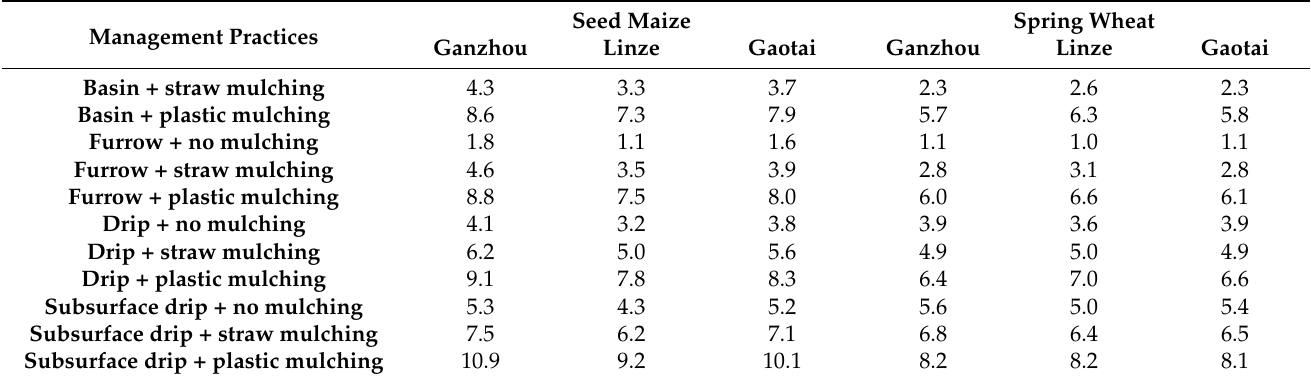
Table 5. Improvements in crop water productivity (%) under different combinations of irrigation methods and soil mulching.